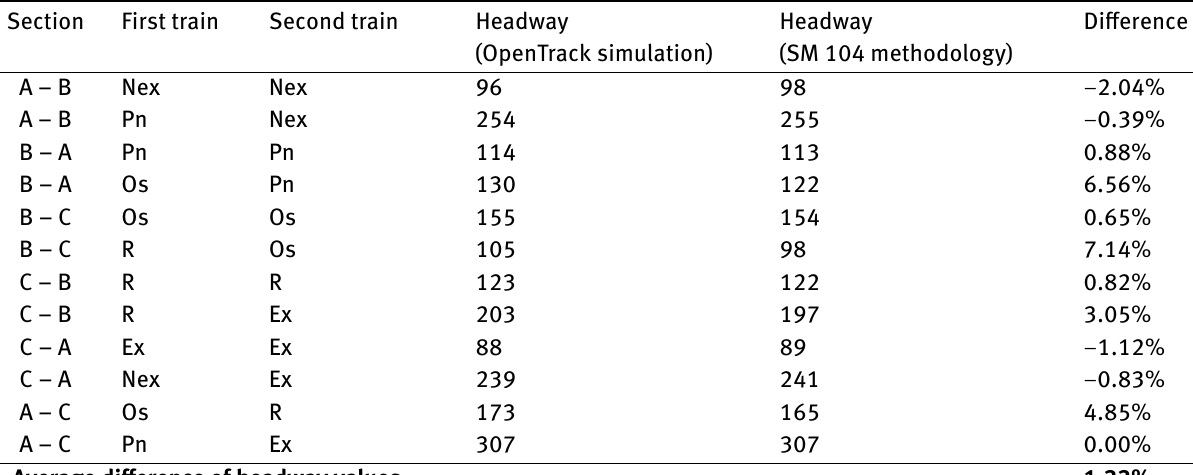
Table 5: Comparison of headway